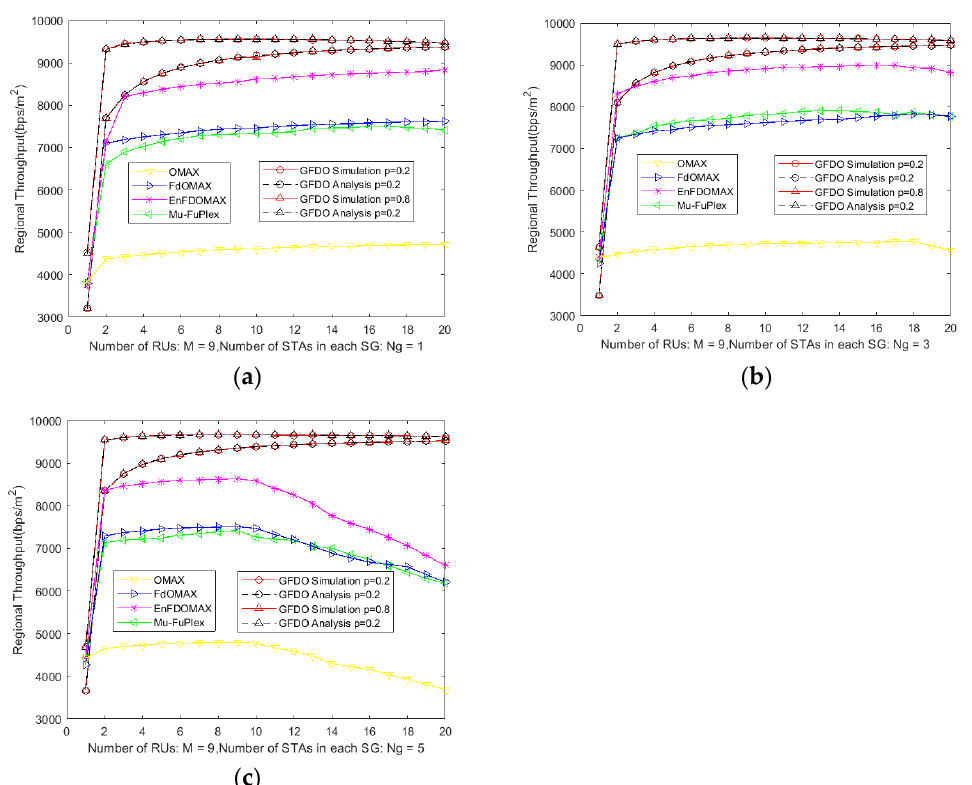
Figure 6. Analysis of area throughput under the number of different nodes. ( a ) Area throughput vs. Number of STAs in each SG is 1; ( b ) Area throughput vs. Number of STAs in each SG is 3; ( c ) Area throughput vs. Number of STAs in each SG is 5.